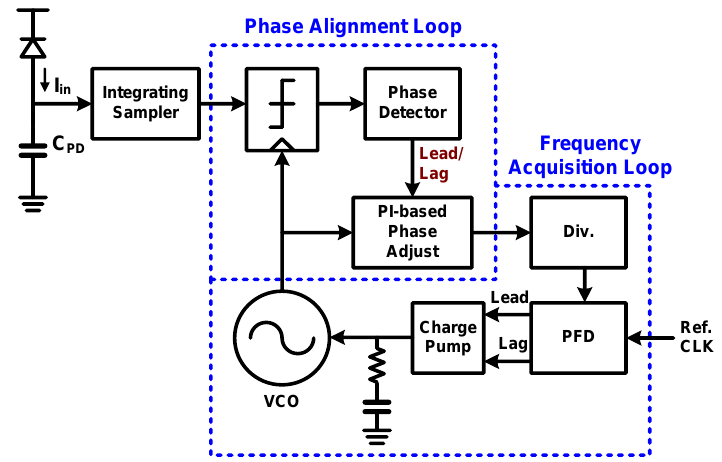
Figure 44. Dual loop CDR with integration-based front-end presented in [78].